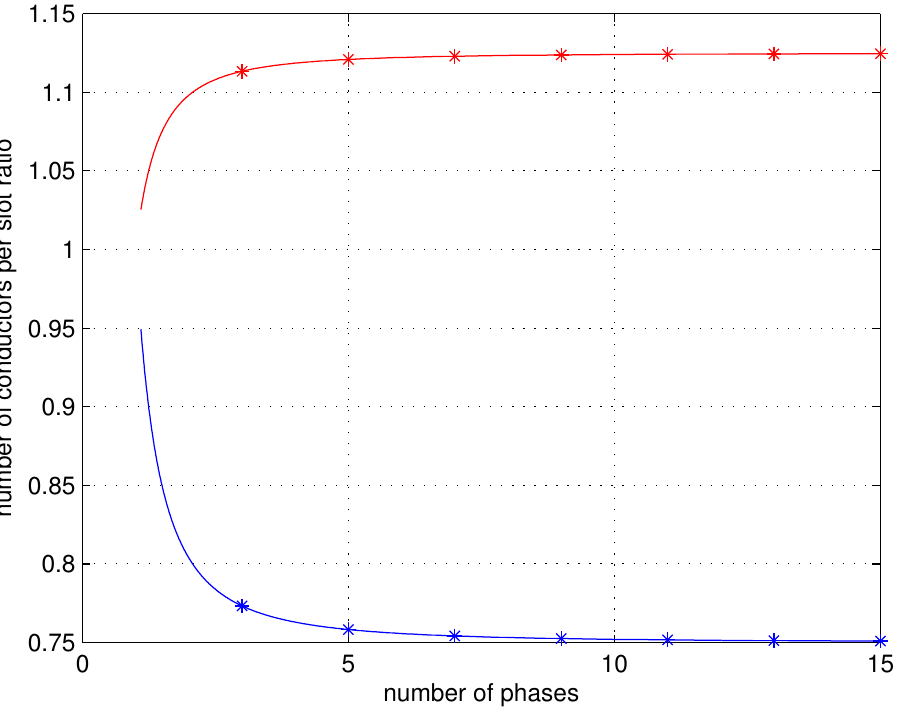
Figure 8. Number of conductors per slot ratio versus the number of phases q . N H + N L 2 N L Legend: (red) , (blue) . 2 N 2 N